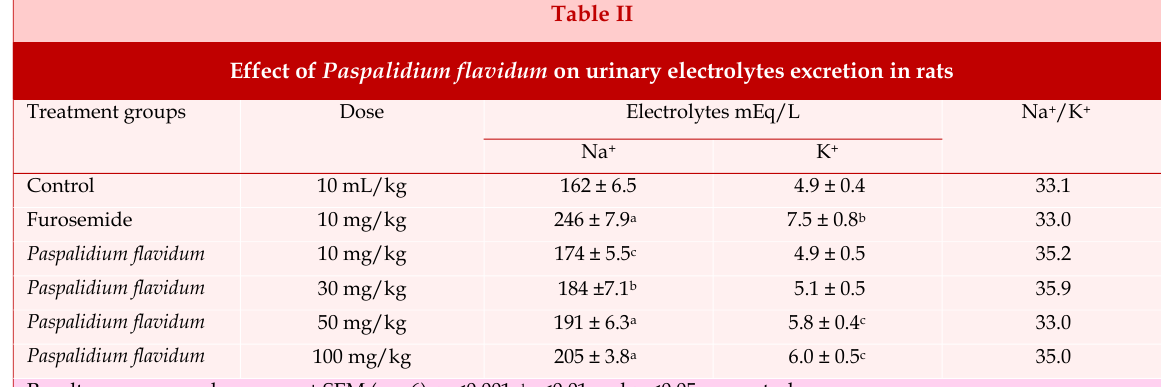
Effect of Paspalidium flavidum on urinary electrolytes excretion in rats Treatment